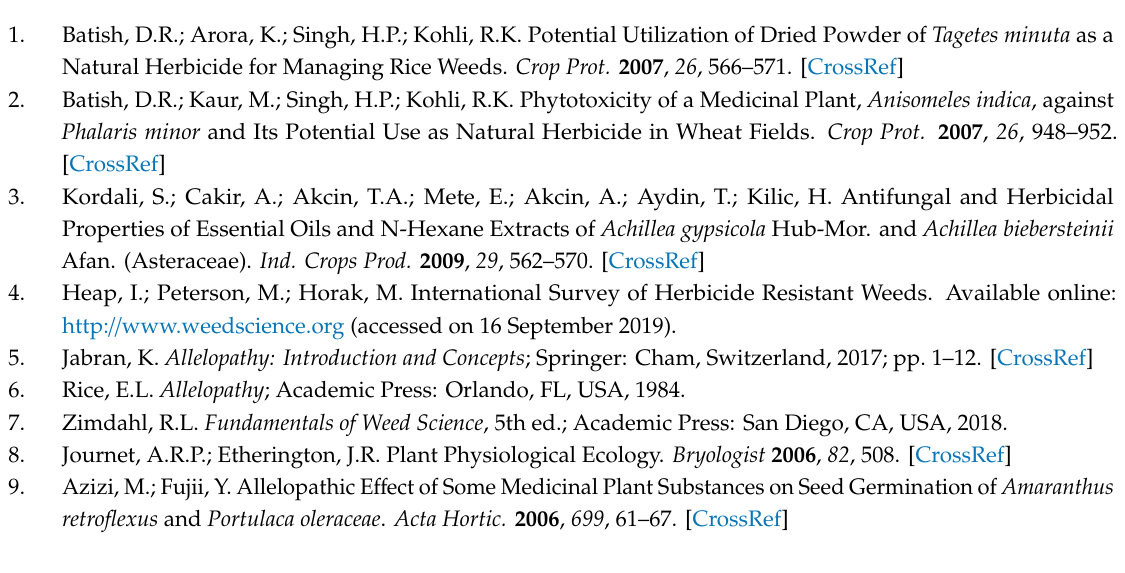
Figure S1: Isobologram curves of allelopathic interaction e ff ects of EOs on lettuce seed germination inhibition by cotton swab method, Figure S2: Isobologram curves of allelopathic interaction e ff ects of EOs on lettuce hypocotyl growth inhibition by cotton swab method, Figure S3: Isobologram curves of allelopathic interaction e ff ects of EOs on lettuce radicle growth inhibition by cotton swab method, Table S1: Analysis of variance of variables studied in the experiment to investigate the e ff ects of 112 essential oils concentrations on seed germination and seedling growth of